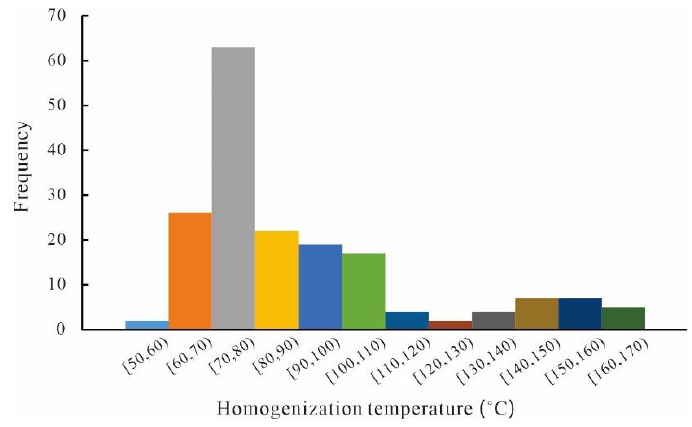
Figure 9. Homogeneous temperature histogram of brine inclusion.